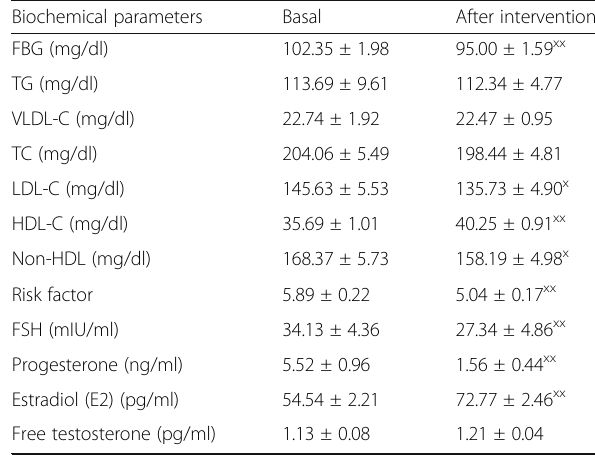
Table 7 Mean ± SE of biochemical parameters of the participants at the basal and the end of the dietary therapy Biochemical